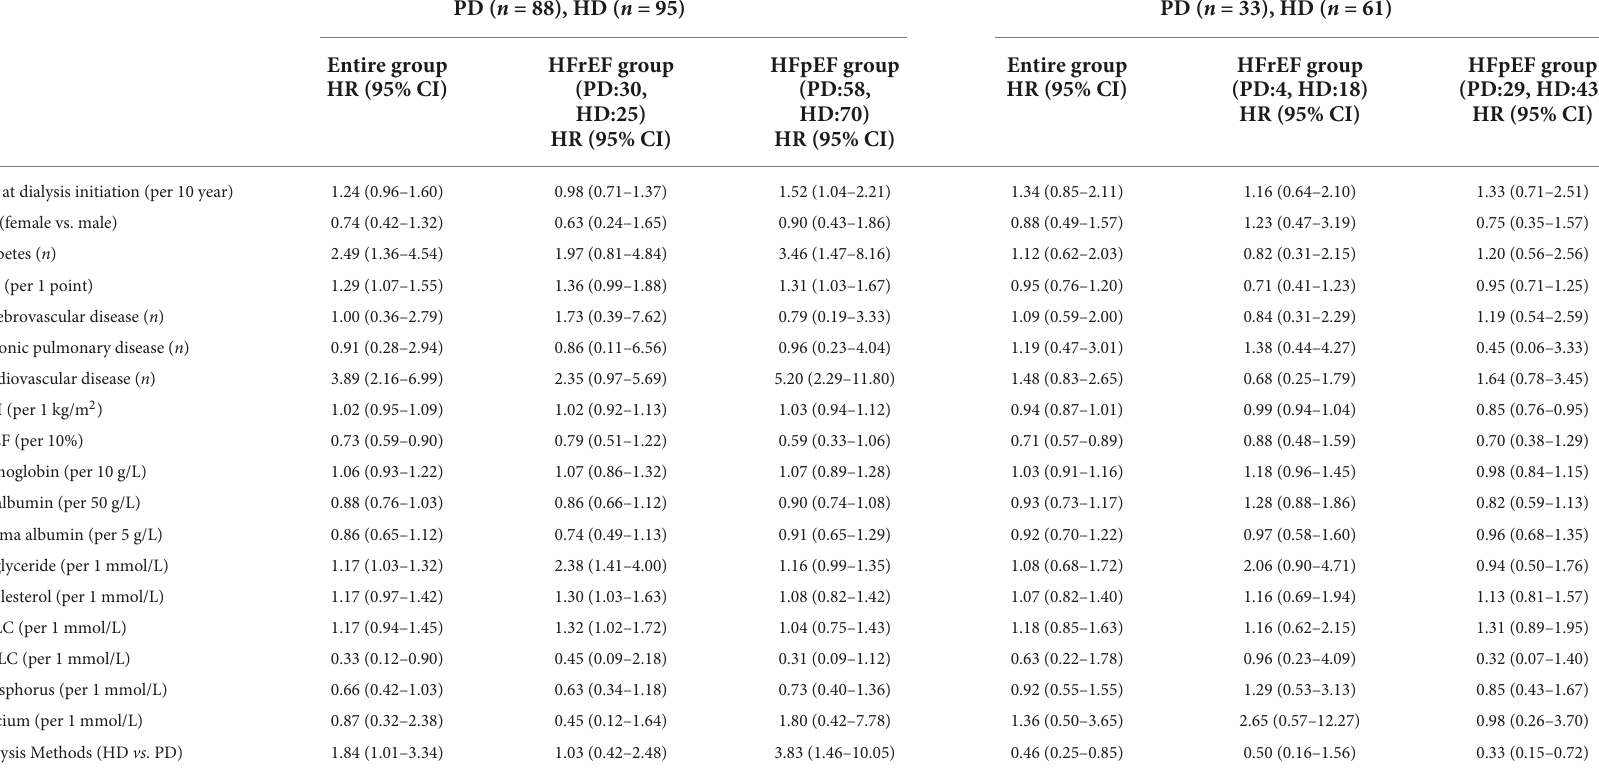
TABLE 3 Risk factors for all-cause mortality assessed by univariate Cox regression